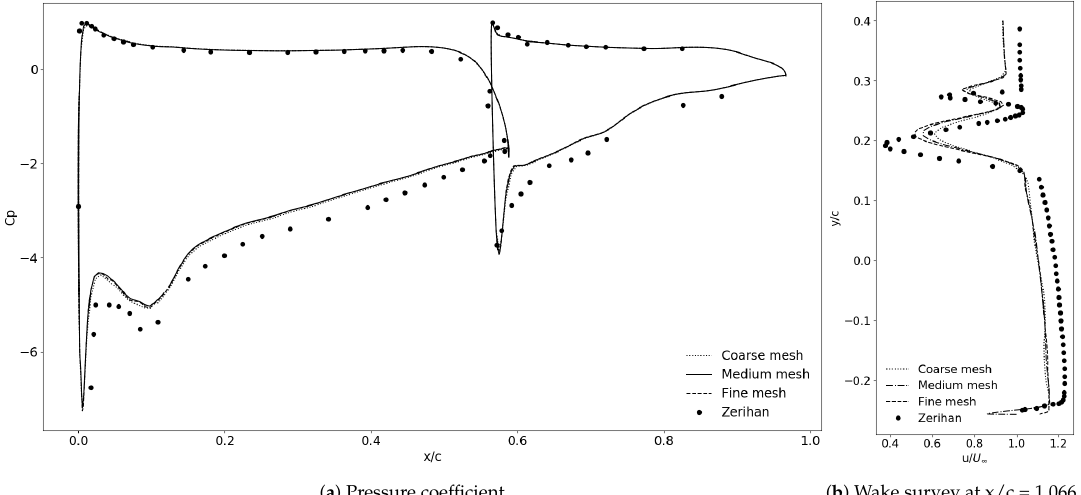
Figure 8. Numerical data at the symmetry plane for all three levels of mesh compared to the Zerihan’s